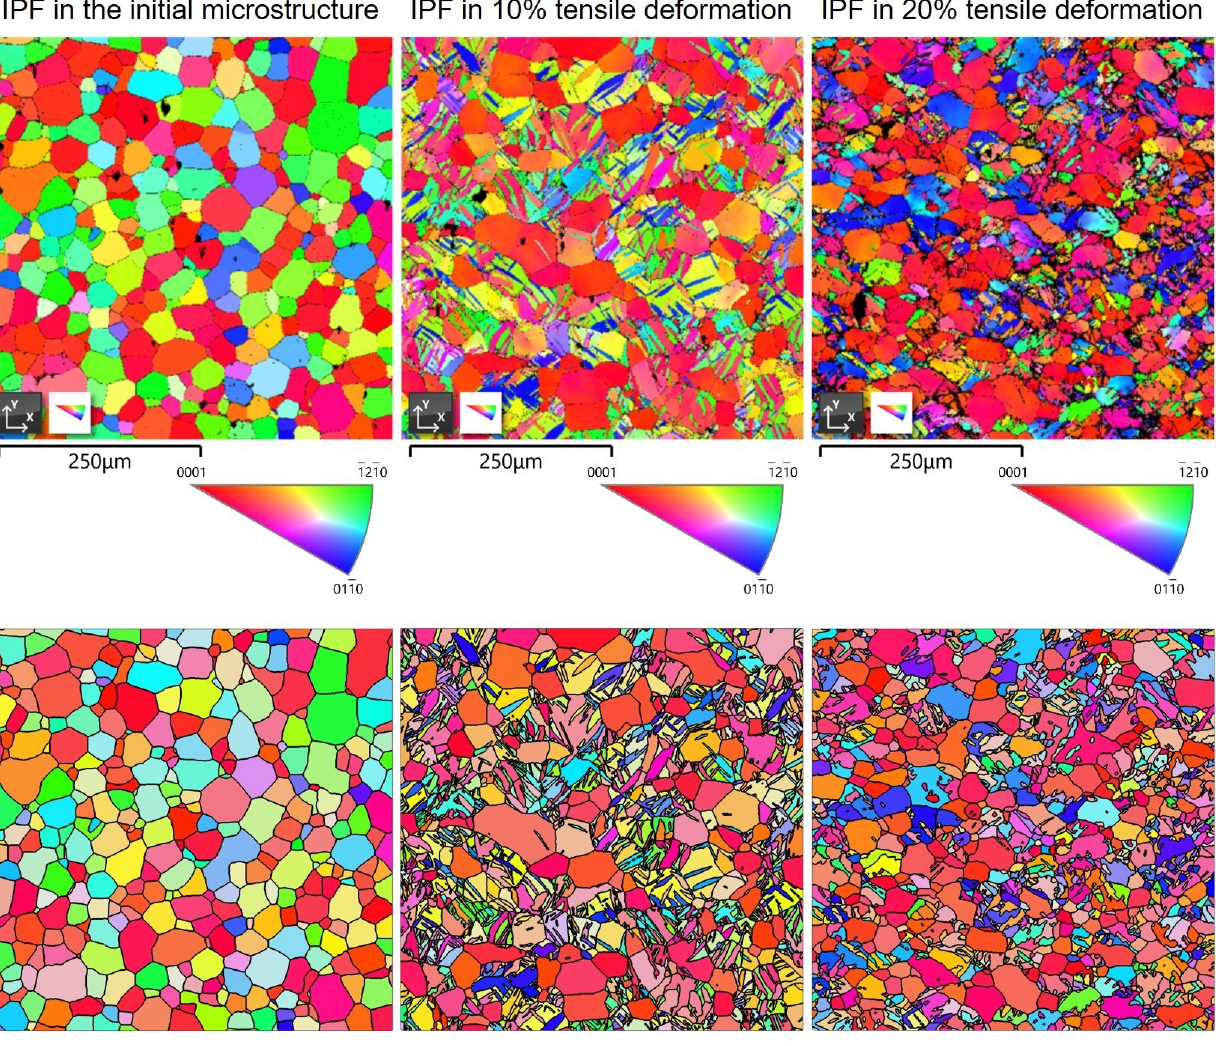
Figure 2. Inverse pole figures of microstructure under 2%, 6%, and 10% tensile